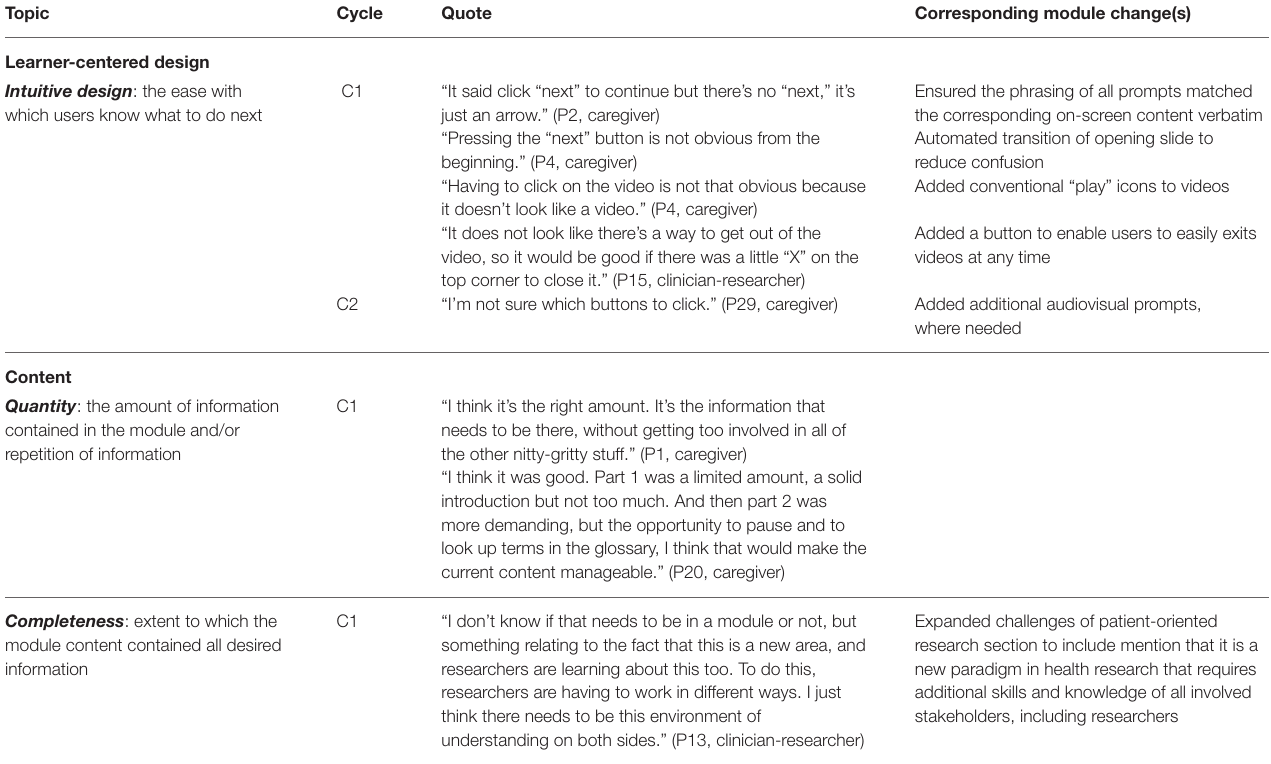
Automated transition of opening slide to reduce